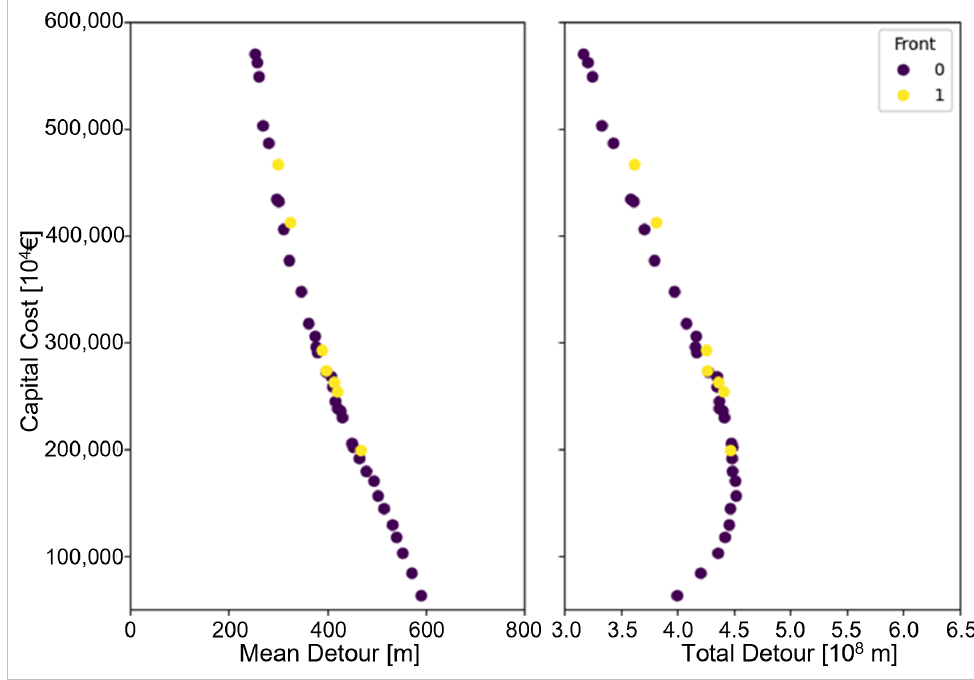
Figure 8. Results of generation